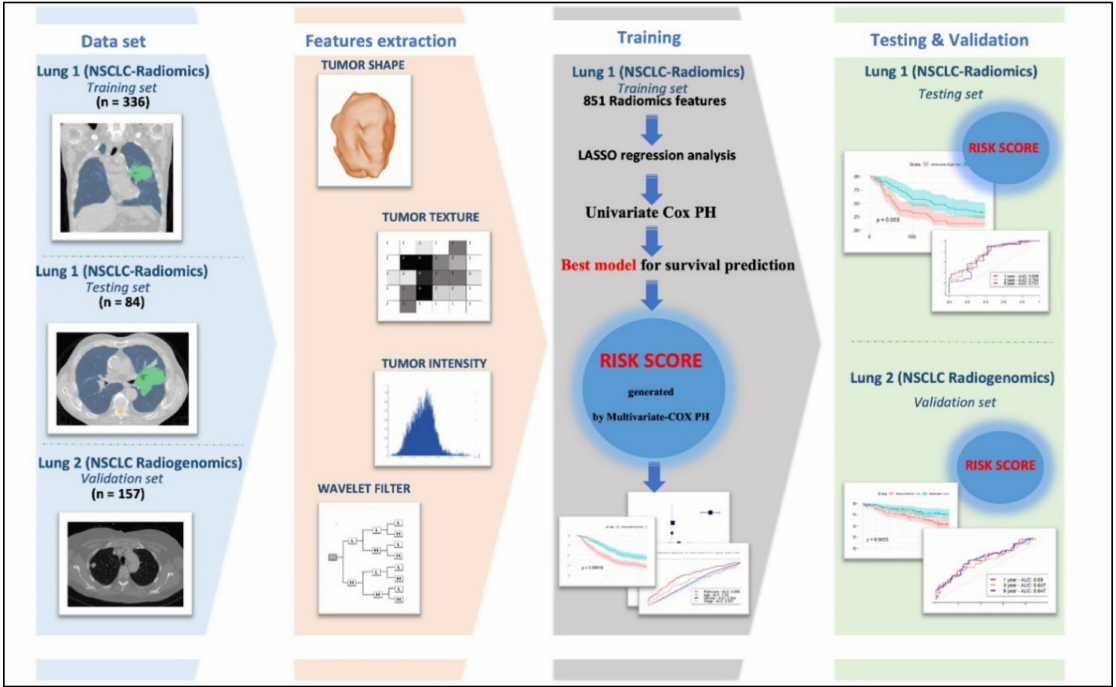
Figure 8. Flow chart of identified radiomics signatures and build the Risk score for survival prediction of the